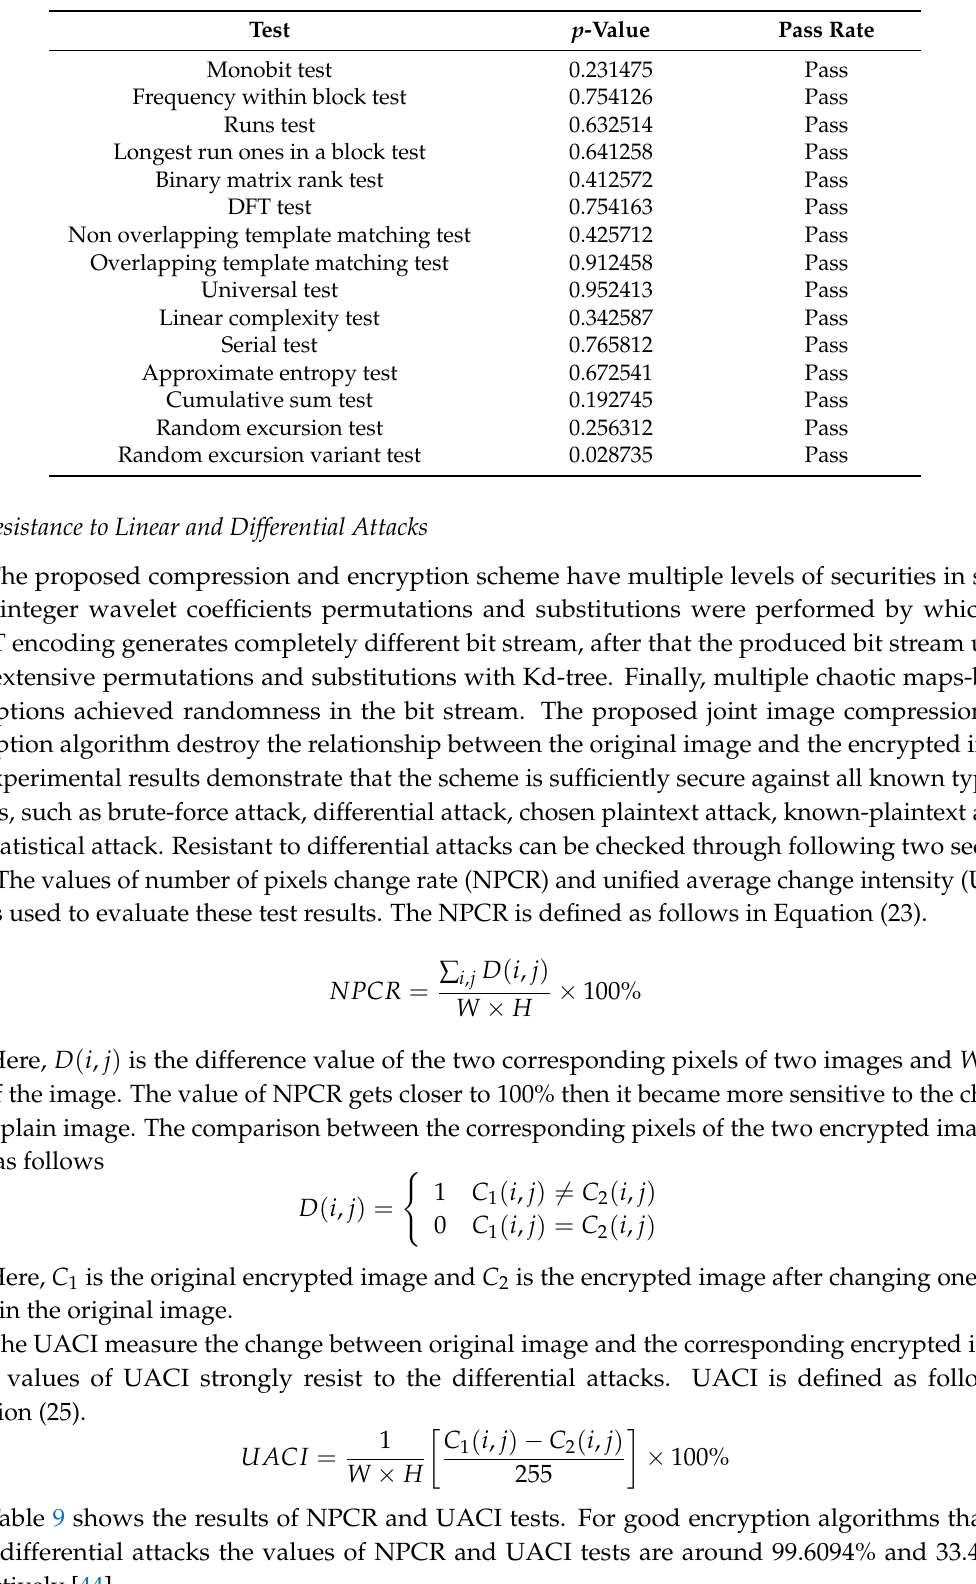
Table 8. NIST SP800-22 tests of encrypted bit